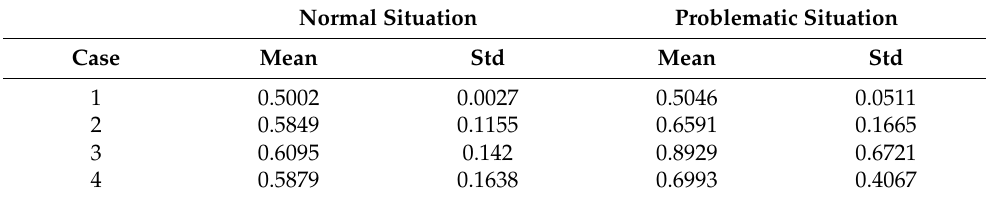
Table 2. Mean and standard deviation of inter-arrival times of control